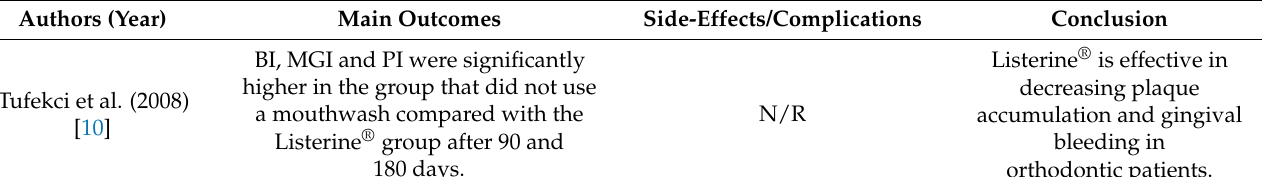
Table 4. Main study